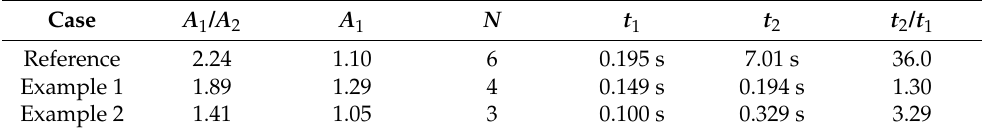
Figure 9. Comparison between reference values, Example 1 values and Example 2 values. The two horizontal dashed lines ( ) represent the + 2.5% interval with regard to the normalized displacement ratio at the stationary value. Table 4. Results comparison rounded to three significant